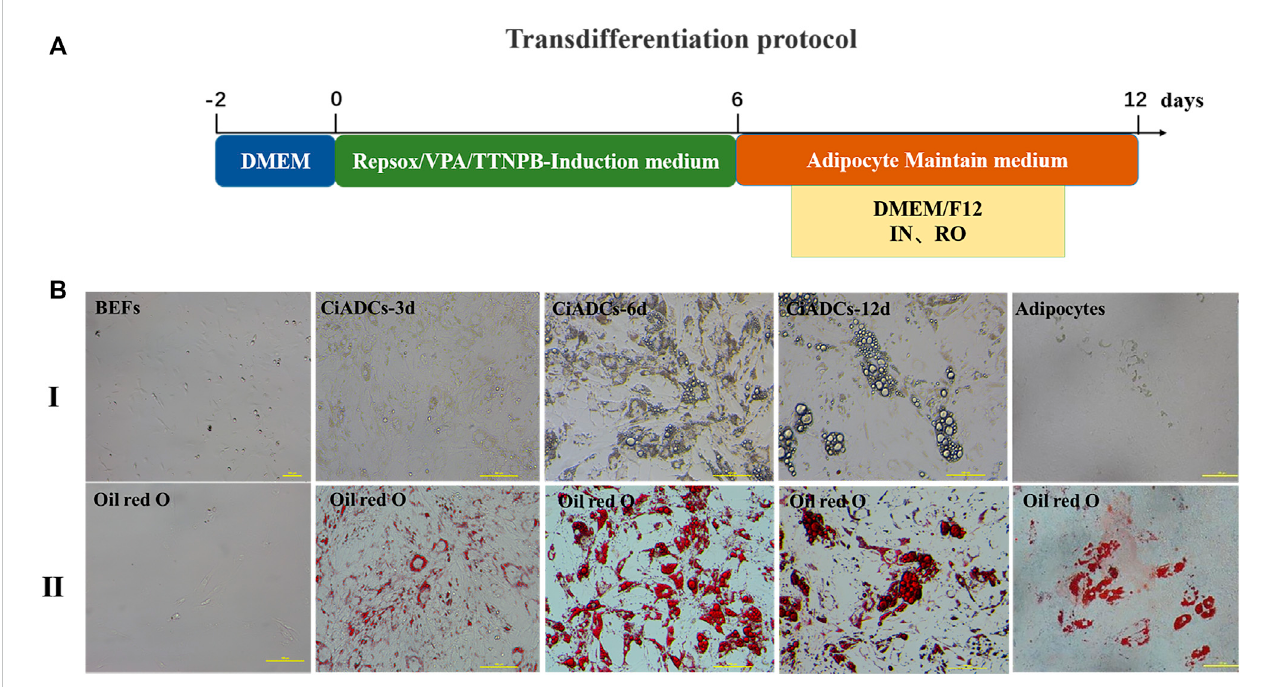
Small-molecule compounds induce the conversion of BEFs into chemically induced adipocyte cells (CiADCs). (A) Diagrammatic sketch of CiADC formation. Induction medium was applied from day 0 to day 6, subsequently adipocyte maintain medium was applied. Induced cells were obtained at day 6 termed adipocyte-like cells. (B) Phase contrast image and oil red O staining of adipocyte-like cells generated from BEFs during the induction process. I. Morphological changes of CiADCs cells from day 0 to day 12 and differentiated adipocytes; II. The oil red O staining for different induction time